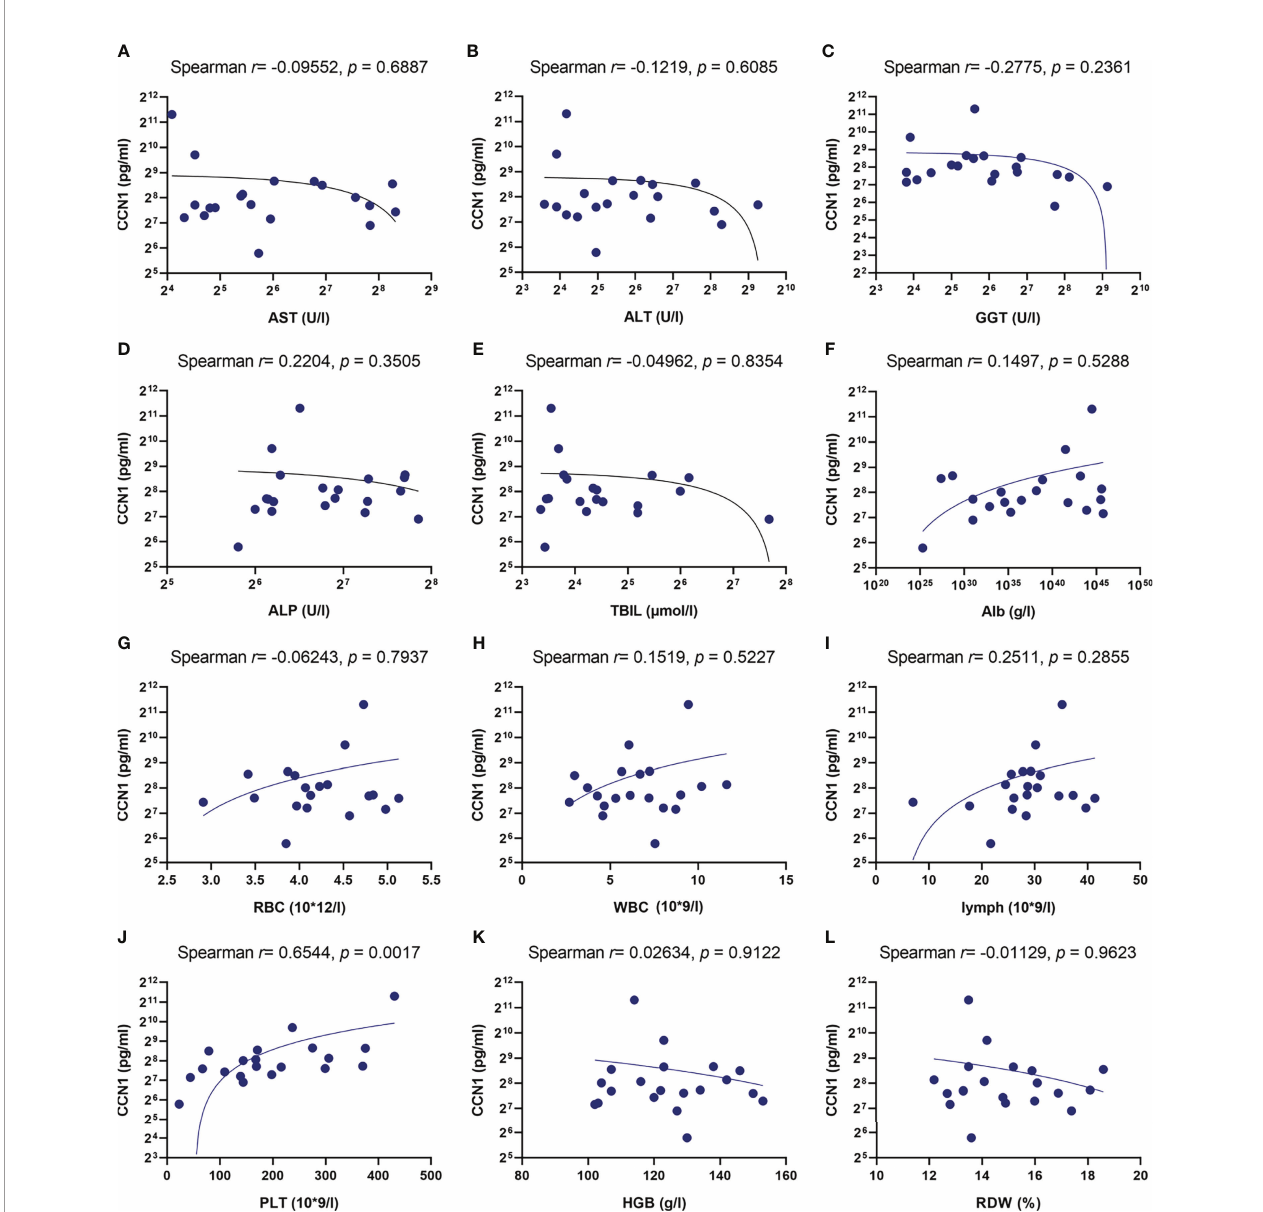
FIGURE 3 | Correlation between CCN1 and liver function and blood routine indexes. (A-L) Correlation between CCN1 and AST, ALT, GGT, ALP, TBIL, Alb, RBC, WBC, lymphocyte, PLT, HGB,